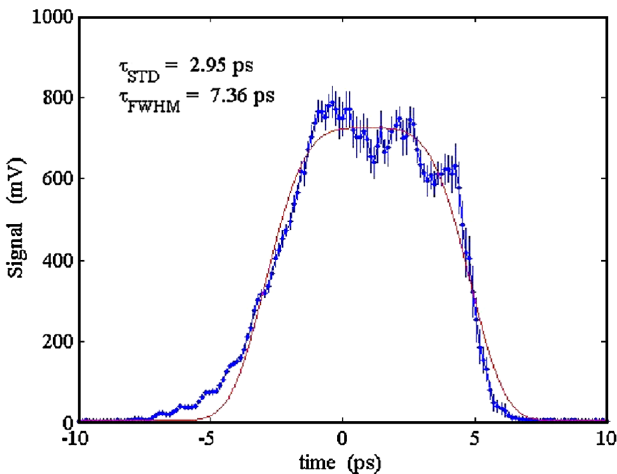
FIG. 3. (Color) Laser temporal profile, with 7.4-ps FWHM pulse length, measured (blue) on the scanning cross correlator, fit with an n th-order super-Gaussian curve (red): f (cid:4) t (cid:5) (cid:6) A (cid:2) exp f(cid:1)j(cid:4) t (cid:1) (cid:5) = (cid:4) 2 1 = 2 (cid:3) (cid:5)j 6 g t 0 laser spot on the cathode. A typical image of the virtual cathode taken during commissioning is shown in Fig. 4.